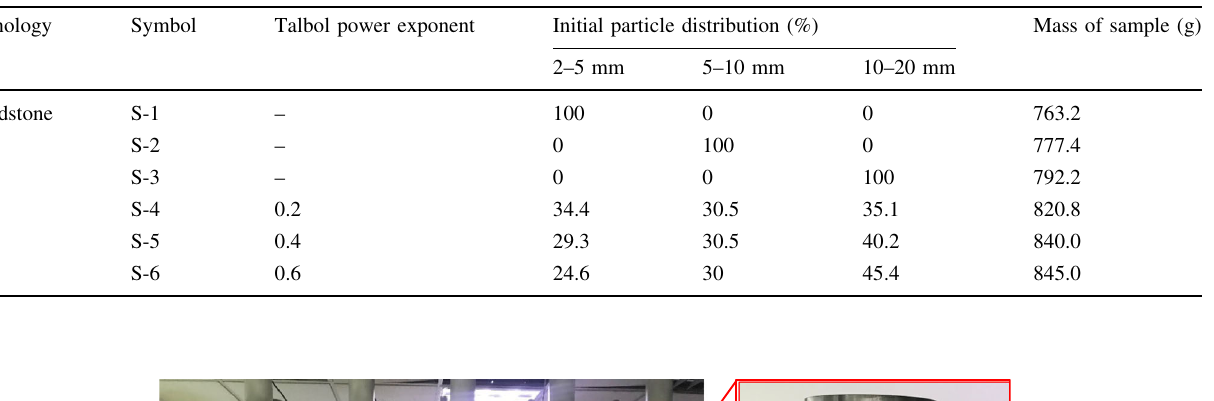
Fig. 2 Grain composition diagram of crushed mudstone samples Table 1 Particle distribution of crushed mudstone samples